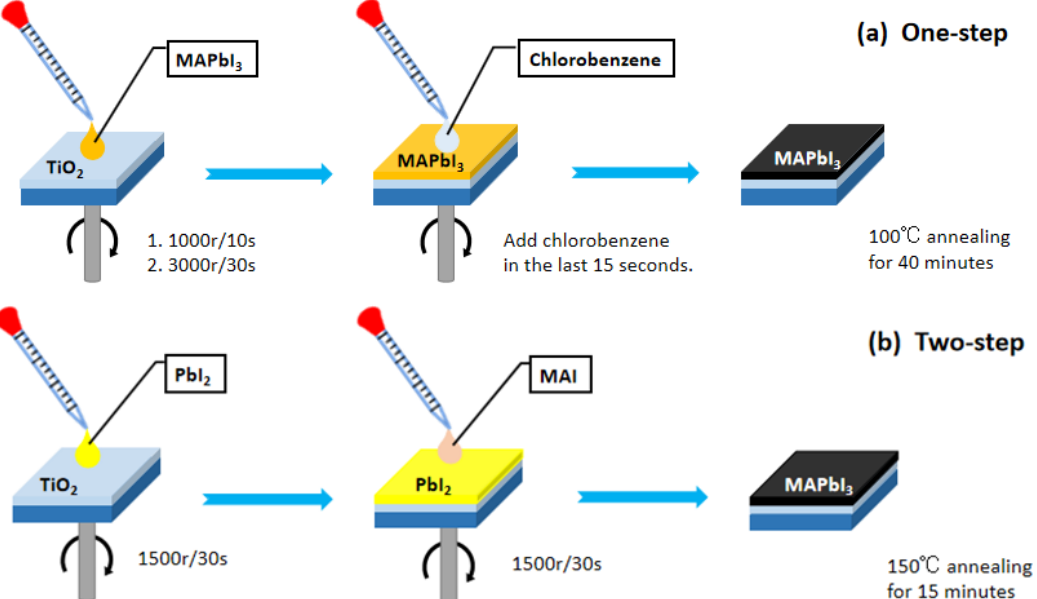
Figure 2. Flow chart of preparation of perovskite film by the one-step ( a ) method and the two-step ( b ) method. ( b ) Figure 2b is the two-step preparation of perovskite film; 0.5993 g PbI 2 (1.3 mol/L) was weighed